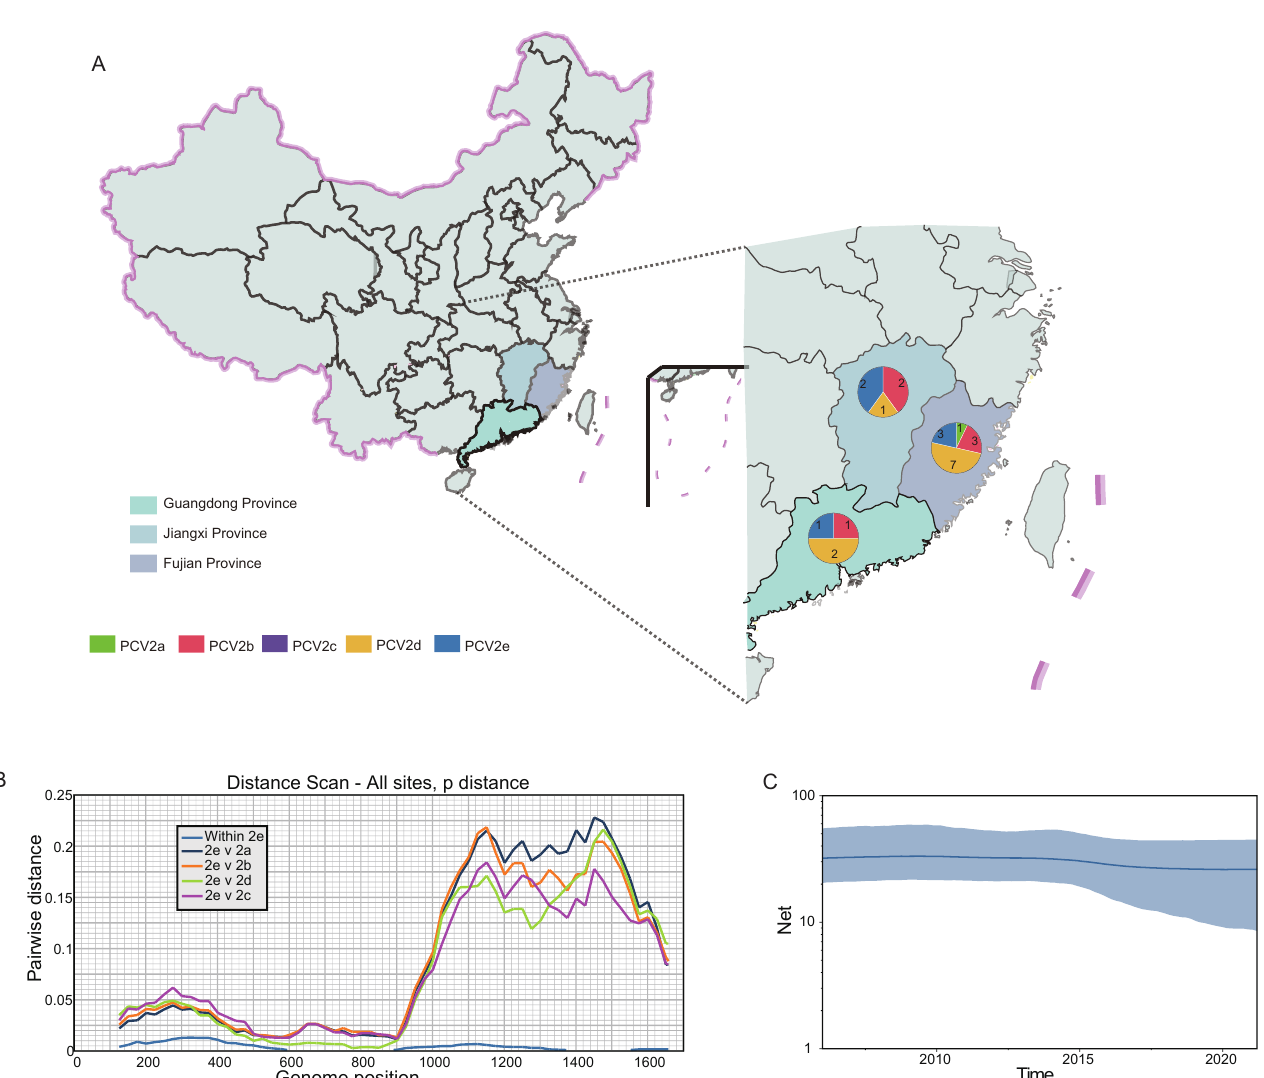
Figure 2. The distribution of sequenced samples, genetic distance, and the population dynamics of PCV2 in southern China. ( A ) Sampling sites. The pie chart and the number represent the proportion and number of PCV2 different genotypes. ( B ) P-distance within the PCV2e genotype and among other genotypes based on whole genomes. ( C ) Population dynamics of PCV2 in southern China. The PCV2 genotypes and provinces are color-coded in the